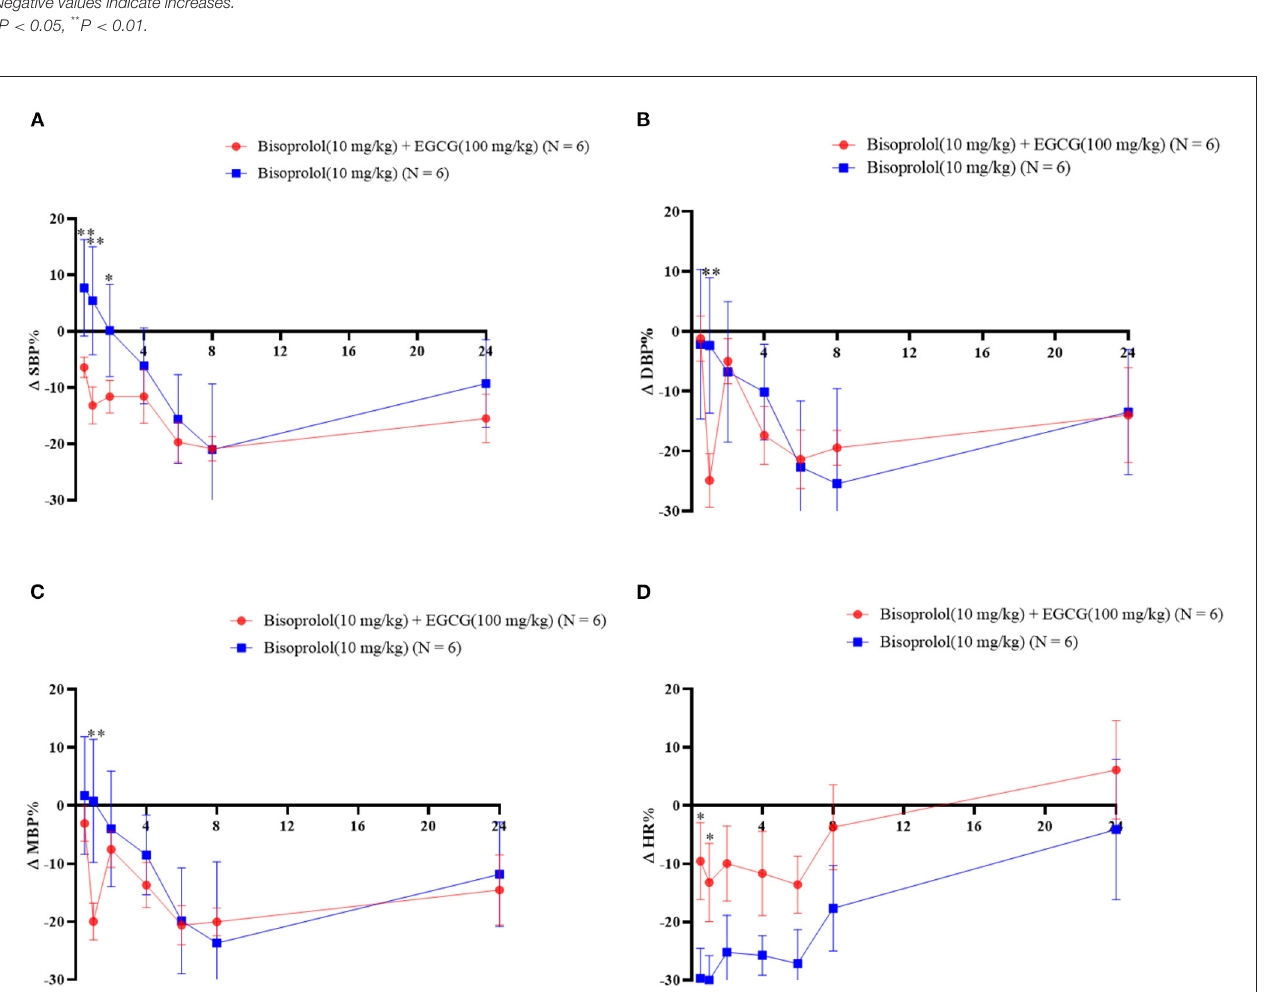
Frontiers in Nutrition |